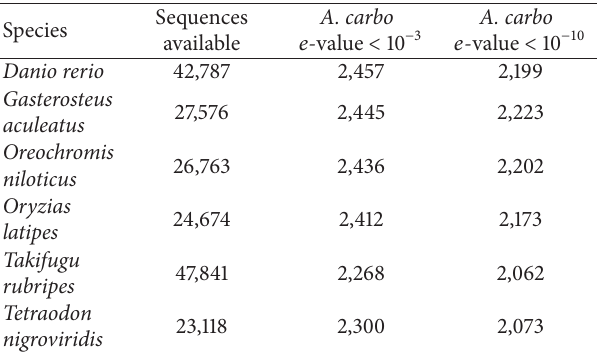
Table 3: Similarity search for unigenes comparing transcriptomes of other teleosts against Aphanopus carbo using two levels of